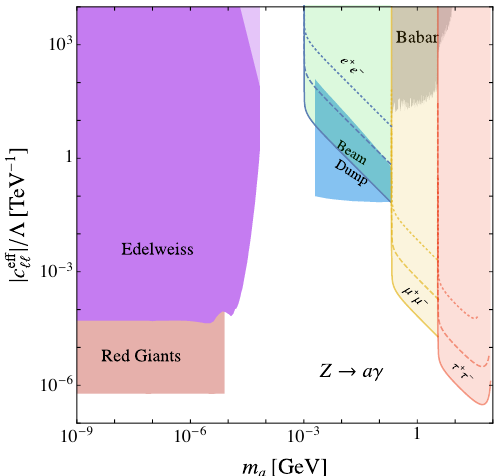
Figure 24 . Constraints on the ALP mass and coupling to leptons derived from various experiments (colored areas without boundaries, adapted from [80, 81]) along with the parameter region that can be probed using the decay Z (cid:13)a (cid:13)e + e (cid:0) . The areas shaded in light green show the reach ! ! of LHC Run-2 with 300 fb (cid:0) 1 of integrated luminosity. We require at least 100 signal events. The contours correspond to C e(cid:11) = (cid:3) = 1 TeV (cid:0) 1 (solid), 0 : 1 TeV (cid:0) 1 (dashed) and 0 : 01 TeV (cid:0) 1 (dotted). (cid:13)Z j j The orange and red regions overlaid in the plots show the corresponding parameter space that can be covered in searches for the decay modes a (cid:22) + (cid:22) (cid:0) and a (cid:28) + (cid:28) (cid:0) (see text for more ! !